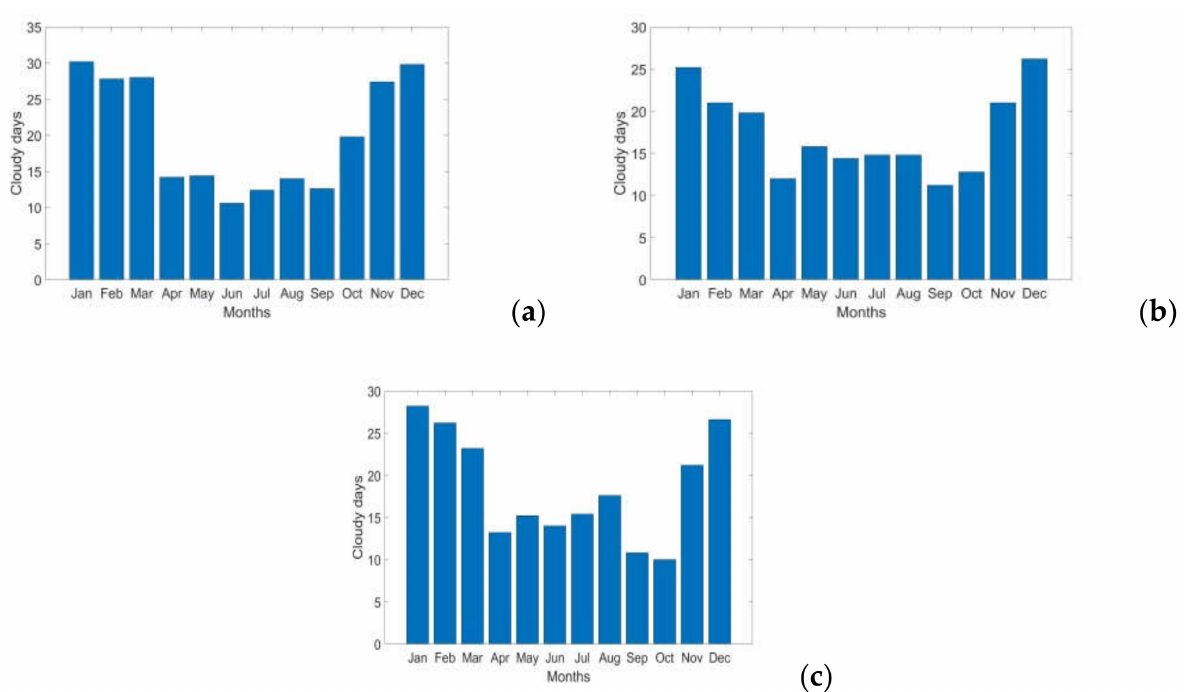
Figure 3. Average number of CCDs per month for the three stations from 2014 to 2018, counted based on MOD10A1; ( a ) station 1, ( b ) station 2, ( c ) station